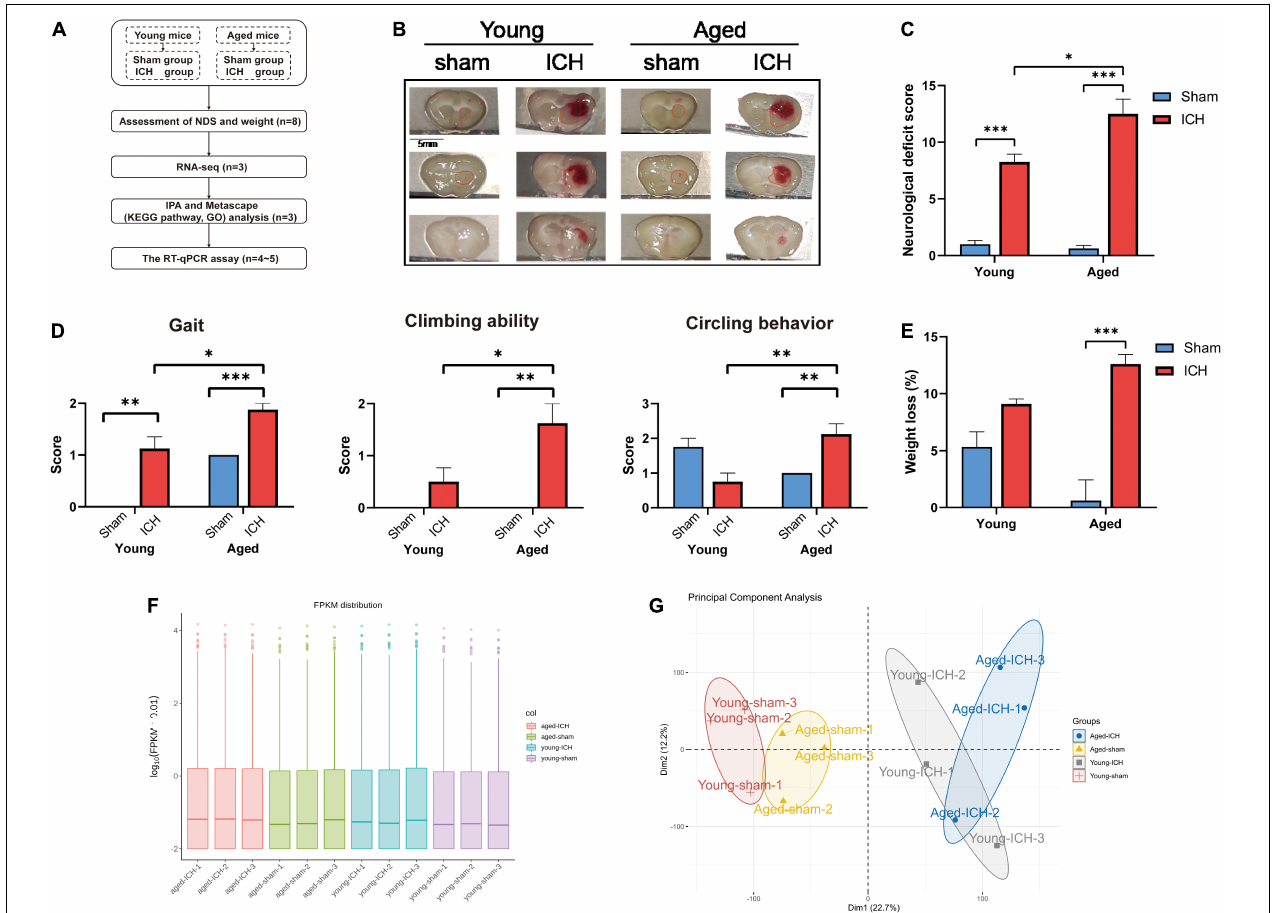
FIGURE 1 | Experimental protocols, sampling regions, the results of behavioral tests, quantification and quality control of RNA sequencing data. (A) Experimental flowchart. ICH, intracerebral hemorrhage; NDS, neurological deficit score; RNA-seq, RNA-sequencing; IPA, ingenuity pathway analysis; KEGG, Kyoto Encyclopedia of Genes and Genomes; GO, gene ontology; RT-qPCR, real-time quantitative polymerase chain reaction. (B) Representative macrographs of coronal brain sections and sampling regions (marked with red traces) from the four groups. (C) Compared to sham surgery, ICH induced significant neurological dysfunction in both aged and young animals ( n = 8); Compared to young mice, ICH induced more severe neurological deficits in aged mice. (D) The comparison of gait, climbing ability, and circling behavior scores between aged and young mice. (E) Body weight was significantly decreased in aged mice with ICH compared with aged sham mice ( n = 8). (F) The box plot of fragments per kilobase of transcript sequence per millions mapped reads (FPKM) distribution per sample. (G) The principal component analysis plot of mRNA expression in the four groups ( n = 3). Dim, dimension. The behavioral data were shown as the mean ± SEM. * P < 0.05, ** P < 0.01, and *** P <